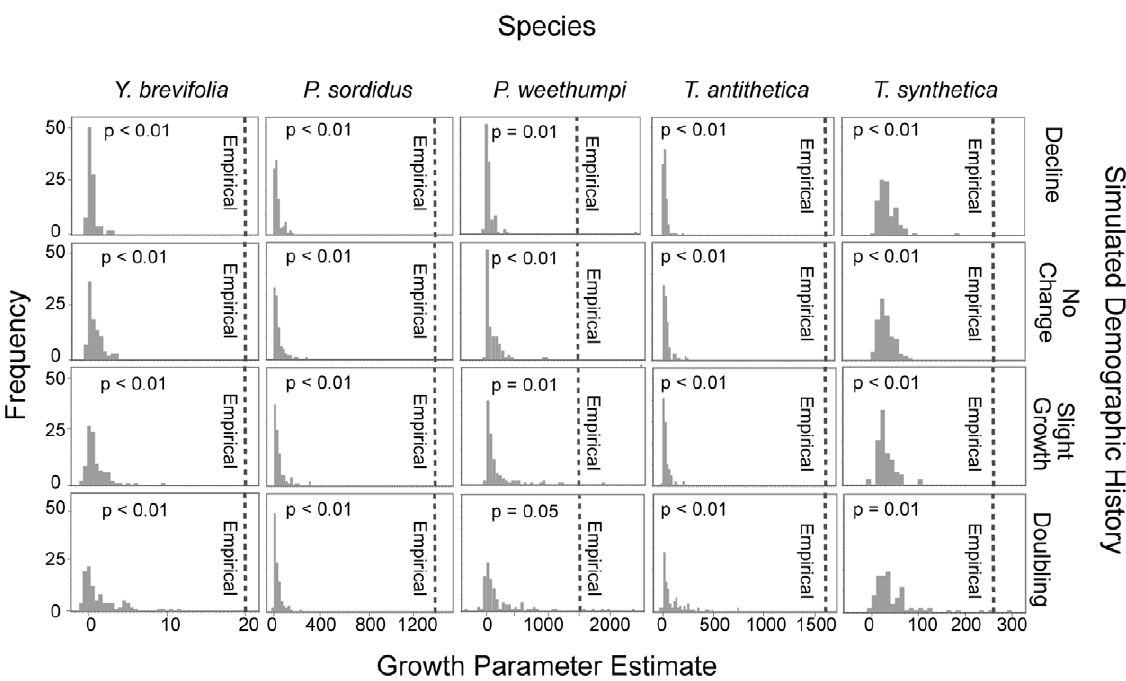
Figure 5. Estimated growth rates in simulated DNA sequence data sets under each of four alternative demographic histories. DNA sequence data were simulated in Mesquite v. 1.12 using models of sequence evolution, mutation rates, and current effective population sizes inferred from the empirical data for each species. Growth rate parameters were estimated in LAMARC v. 2.1.2b. Dashed lines show the empirically estimated growth rate parameter for each species; p values show the probability of observing values as large, or larger under each demographic